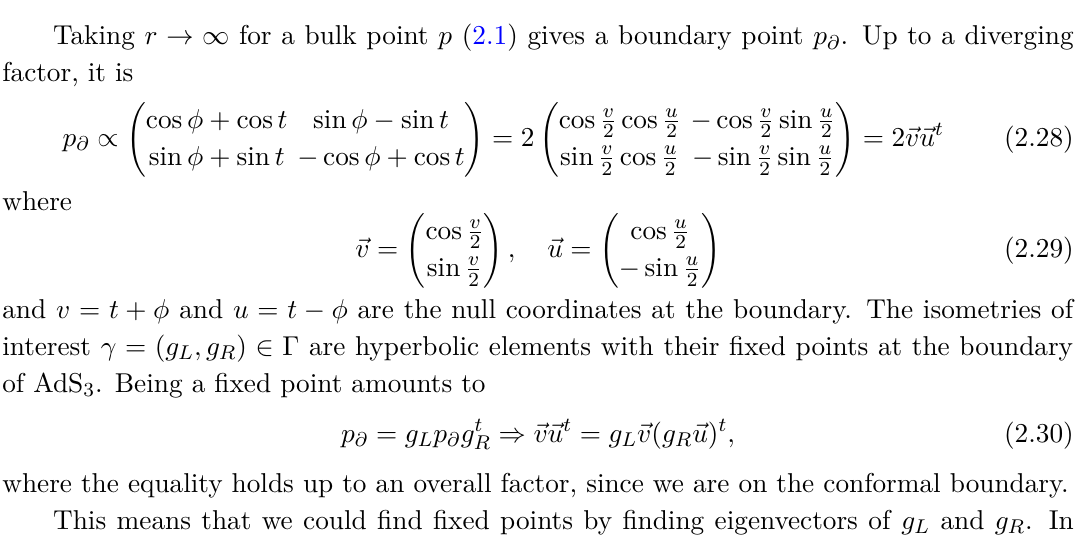
Figure 4. Construction of the (4 , 0) and (1 , 1) geometries using two and one pairs of pants, respectively. The dashed lines represent horizons of asymptotic regions. Note that each pair of pants is constructed from the process shown in figure 3, but here the shape of the Riemann surface is shown